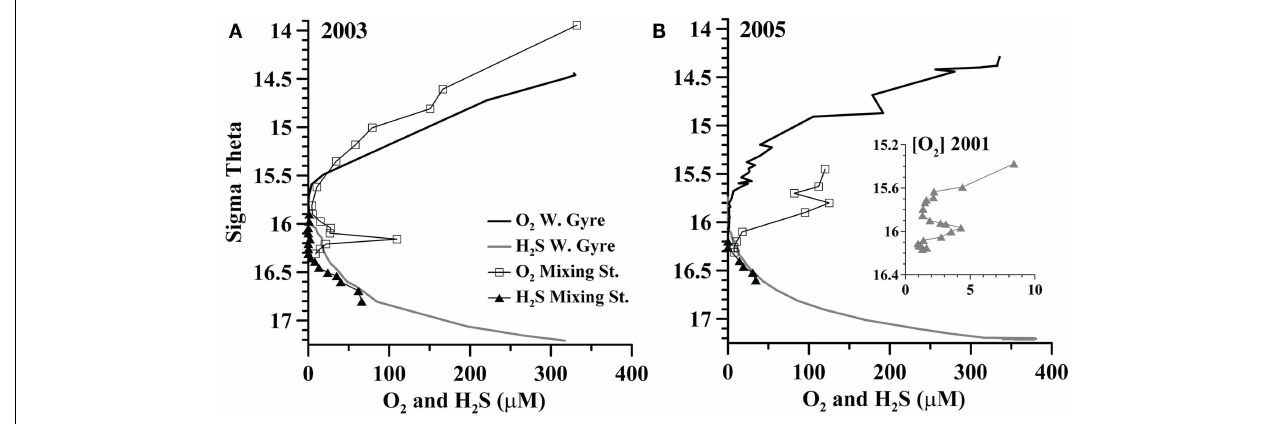
FIGURE 2 |A comparison between oxygen and sulfide in theWestern Gyre and mixing zone stations in (A) 2003 and (B) 2005. Inset: oxygen from the Western Gyre in 2001 during an intrusion